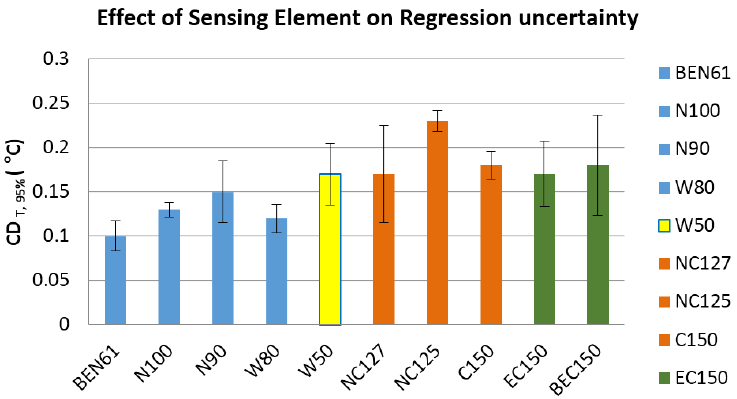
Figure 17. Effect of sensing element on regression uncertainty.